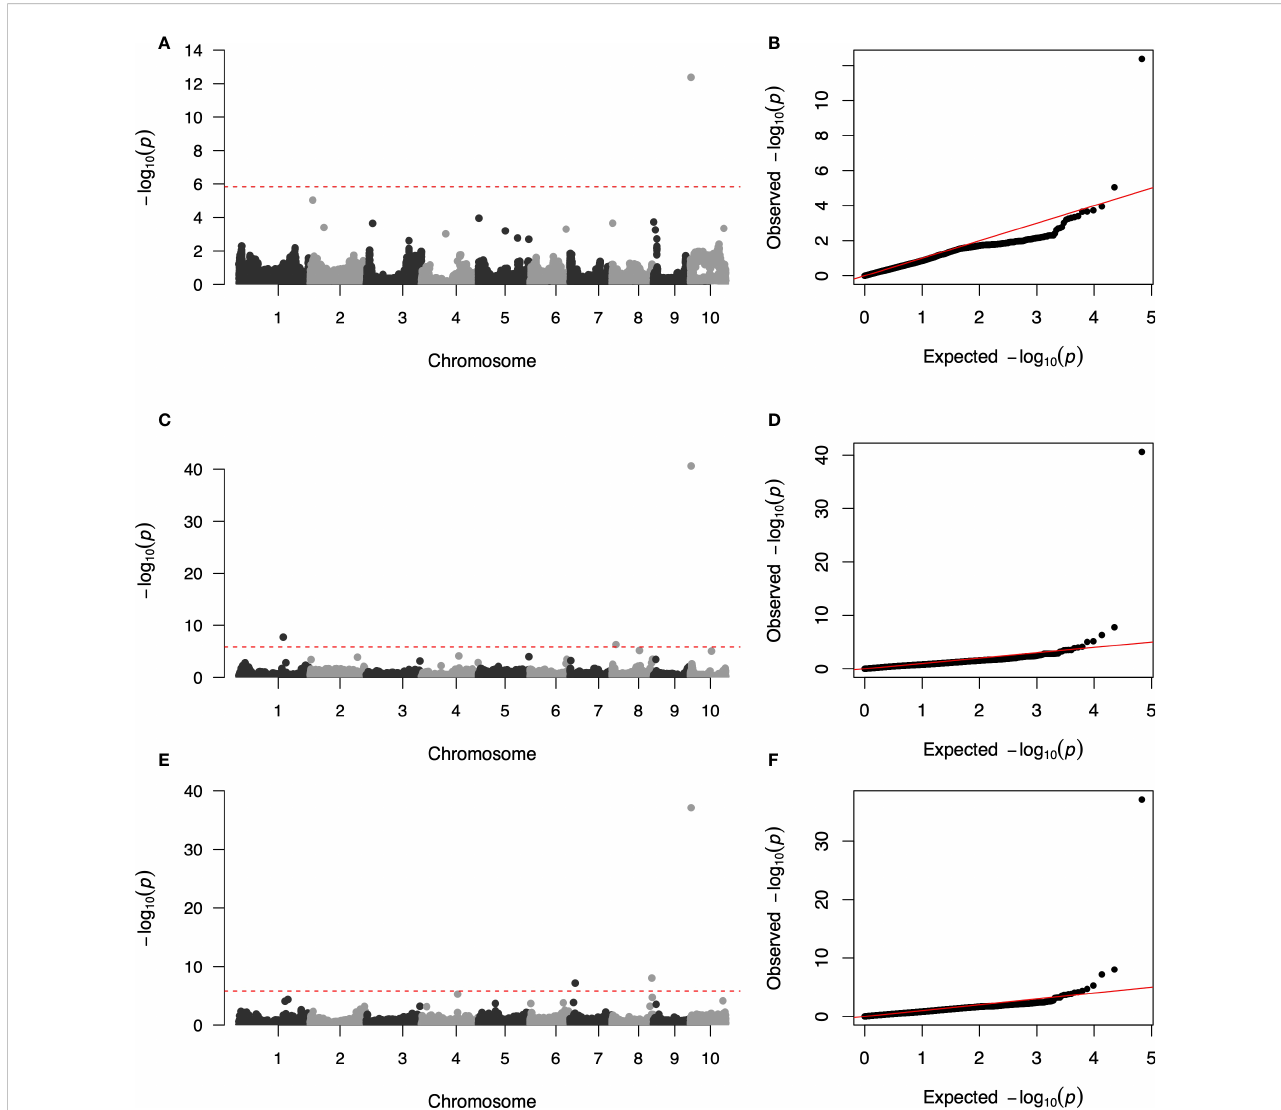
FIGURE 3 Genome-wide association study Manhattan and quantile – quantile (q – q) plots for Southern Corn Rust (SCR) resistance. (A, C, E) Manhattan plots for SCR resistance in additive GWAS in DH panel, additive and dominant GWAS in hybrid panel, respectively. the dashed line corresponds to the threshold level de fi ned at P = 1.47×10 − 6 by a false discovery rate correction method. (B, D, F) q – q plot for SCR resistance in additive GWAS in DH panel, additive and dominant GWAS in hybrid panel,